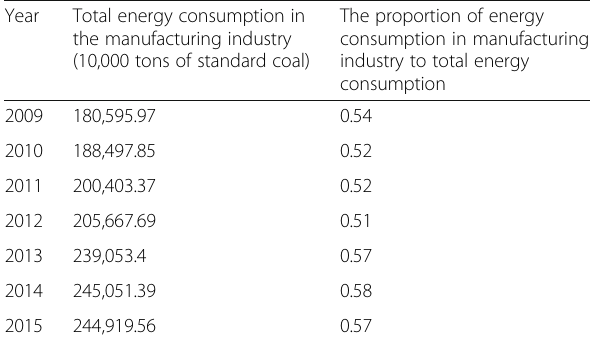
Table 4 Energy consumption in the manufacturing